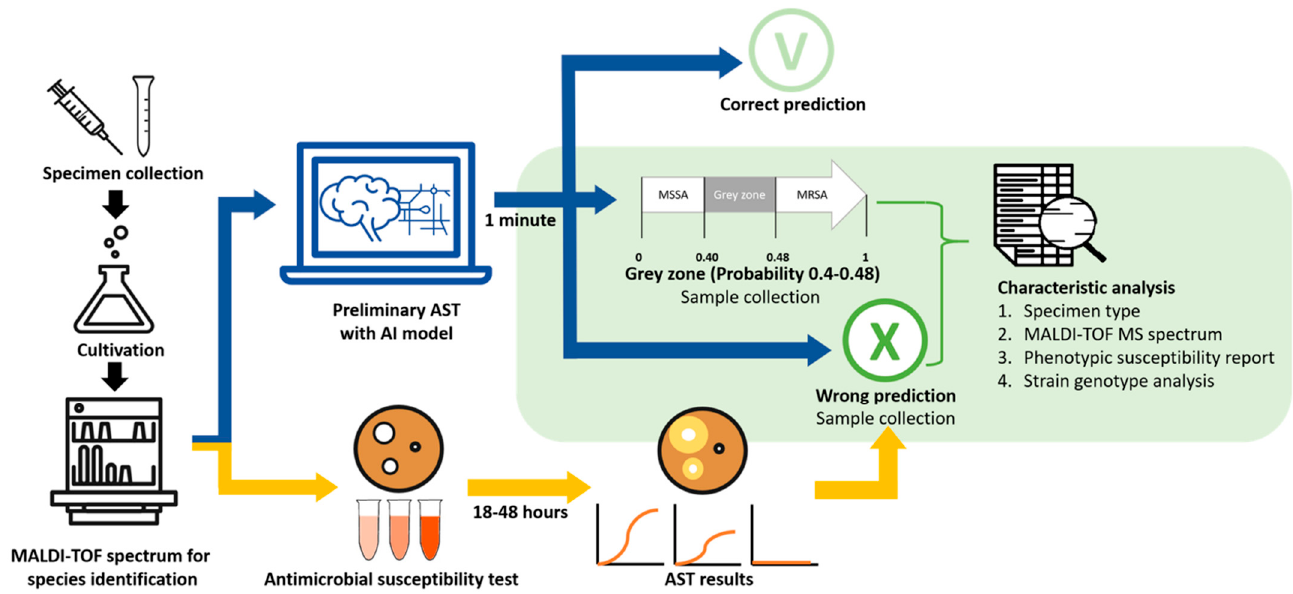
Figure 1. Schematic illustration of the study. The antibiotic susceptibility test (AST) is predicted by analyzing MALDI-TOF spectra with the artificial intelligence (AI) model. Based on the predictive probability generated by the AI model, cases with a probability of less than 0.4 were predicted as susceptible, whereas cases whose probability was larger than 0.48 were predicted as resistant. In contrast, the cases whose probabilities lie between 0.4 and 0.48 were defined as “grey zone”. In addition, cases whose predictive ASTs are different from final ASTs are categorized as “wrong prediction”, while those whose prediction matches final AST are “correct prediction”. We collected “grey zone” and “wrong prediction” cases for further analysis.